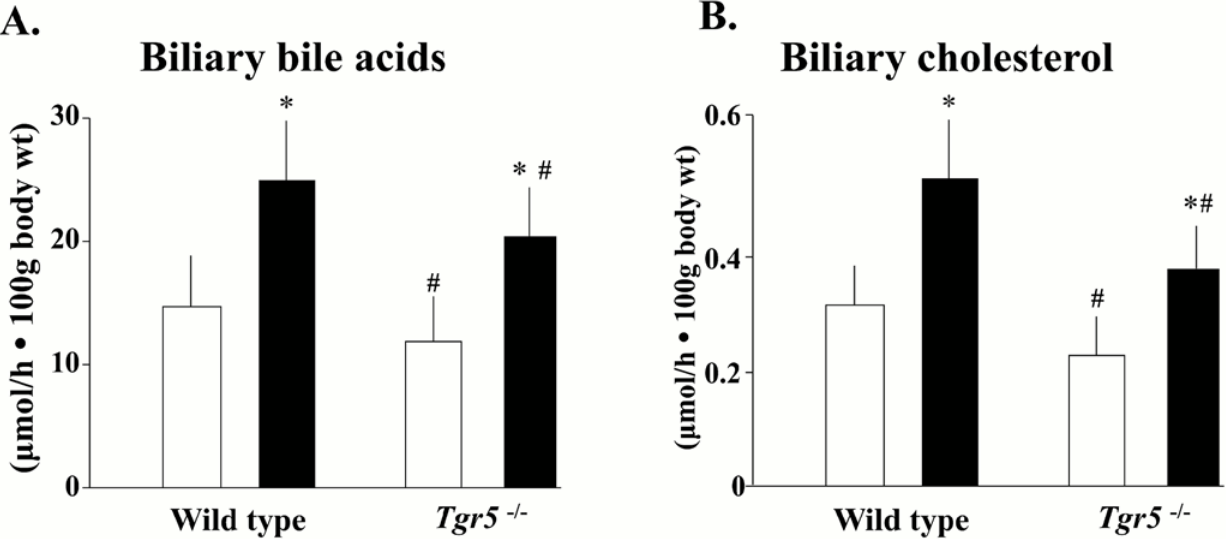
Fig 2. Effect of XGB on biliary BAs and cholesterol secretion rates in wild-type and Tgr5 -/- mice. Panel A represents biliary BAs secretion rates and panel B represents biliary cholesterol secretion rates measured 40 to 45 days after XGB or sham operation. Bile fistulas were established and bile flow was measured at the middle of the light phase of the diurnal cycle. White bars represent sham — operated mice and black bars represent mice subjected to XGB. There were 5 to 8 animals in each group. Values represent the mean ± S.E.M. * p < 0.02; # p < 0.05 compared with the wild type